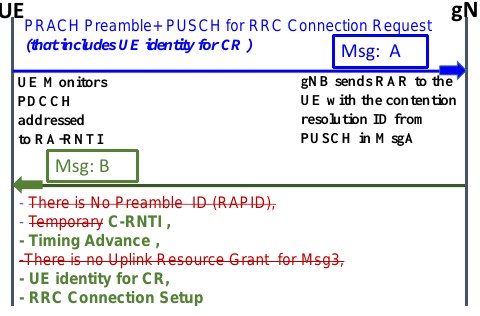
Figure 1. Two step RAP